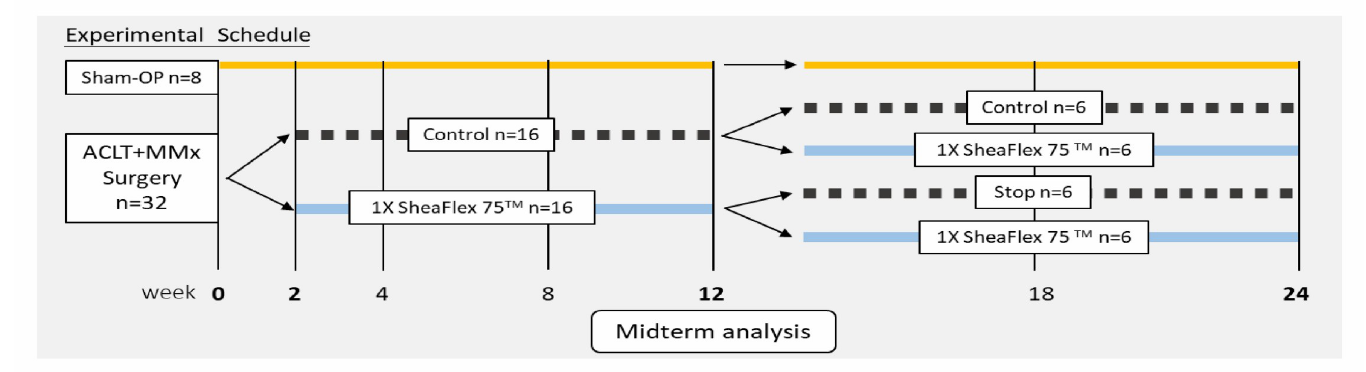
Fig 1. Experimental design and the time course of the